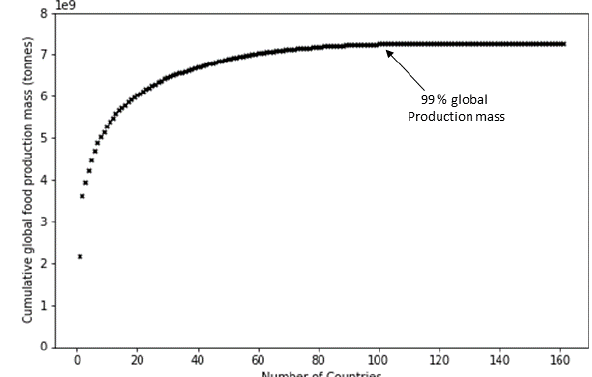
Figure A1. Cumulative food production mass for the year 2017 of all current countries in the FAOSTAT database; dissolved states are not included.